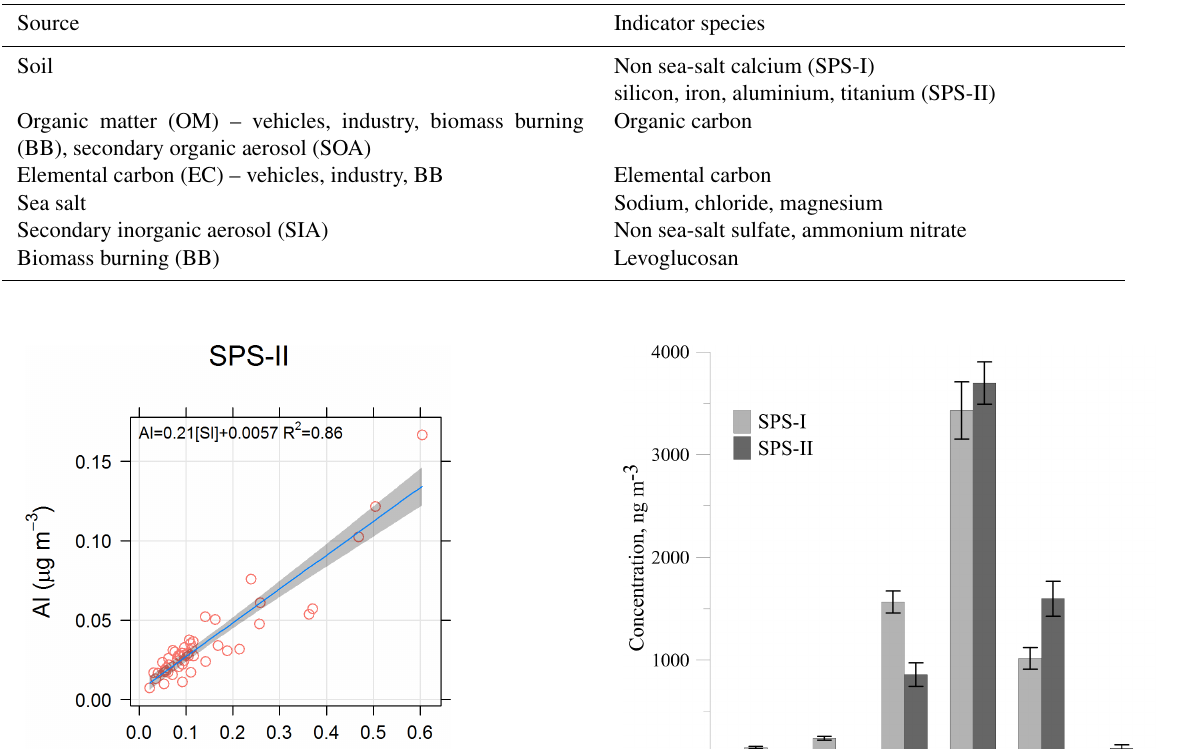
Table 2. Sources and their indicator species.